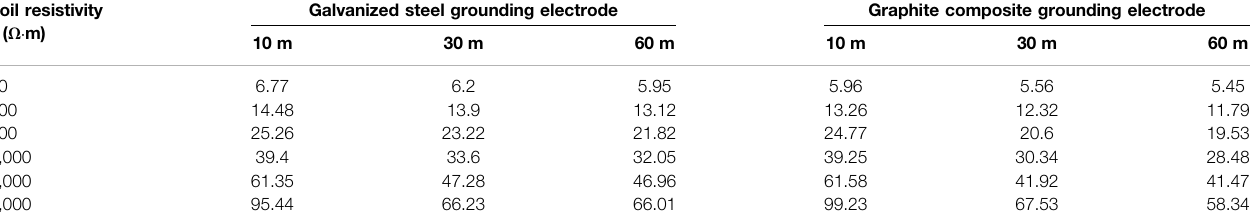
TABLE 6 | Impulse grounding impedance R ch of different material grounding electrodes ( Ω ). Soil resistivity ρ ( Ω · m)